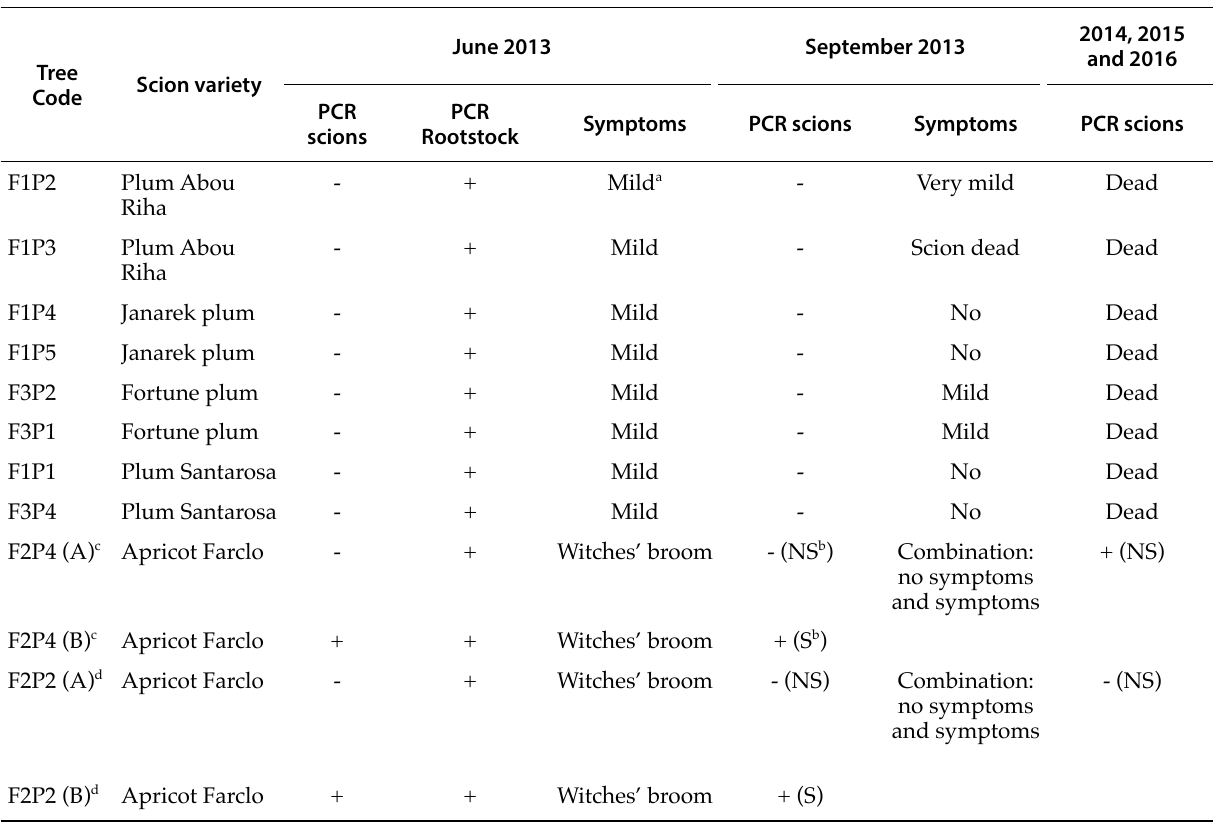
Table 4. Field experiment: symptom development on scions and PCR results using ‘Ca. P. phoenicium’ primers (AlmF2/ R2), 2 and 5 months post grafting and 1 and 2 years post